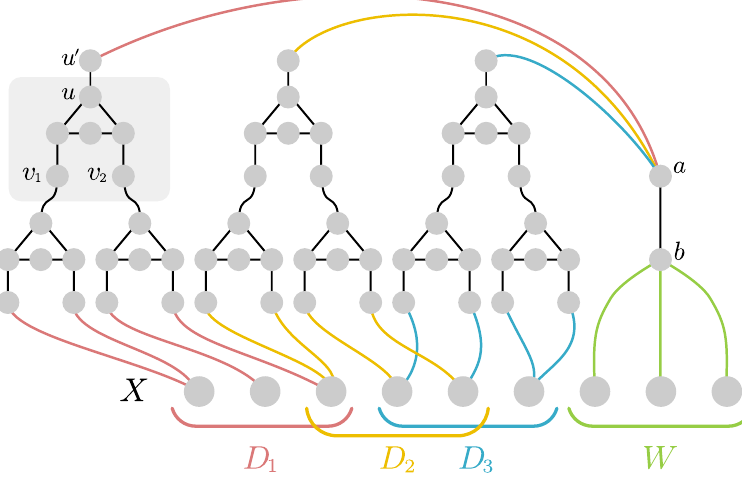
Figure 2. The gadget ◦ Γ W for D W = { D 1 , D 2 , D 3 } . Padding-vertices are not